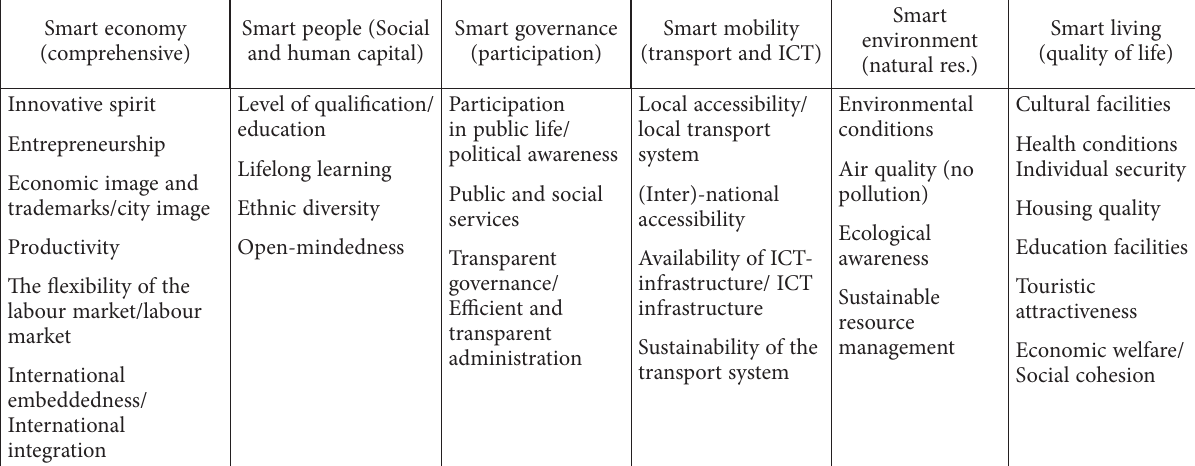
Table 1. List of indicators of smart city characteristics (Giffinger et al., 2007, p. 12) Smart economy